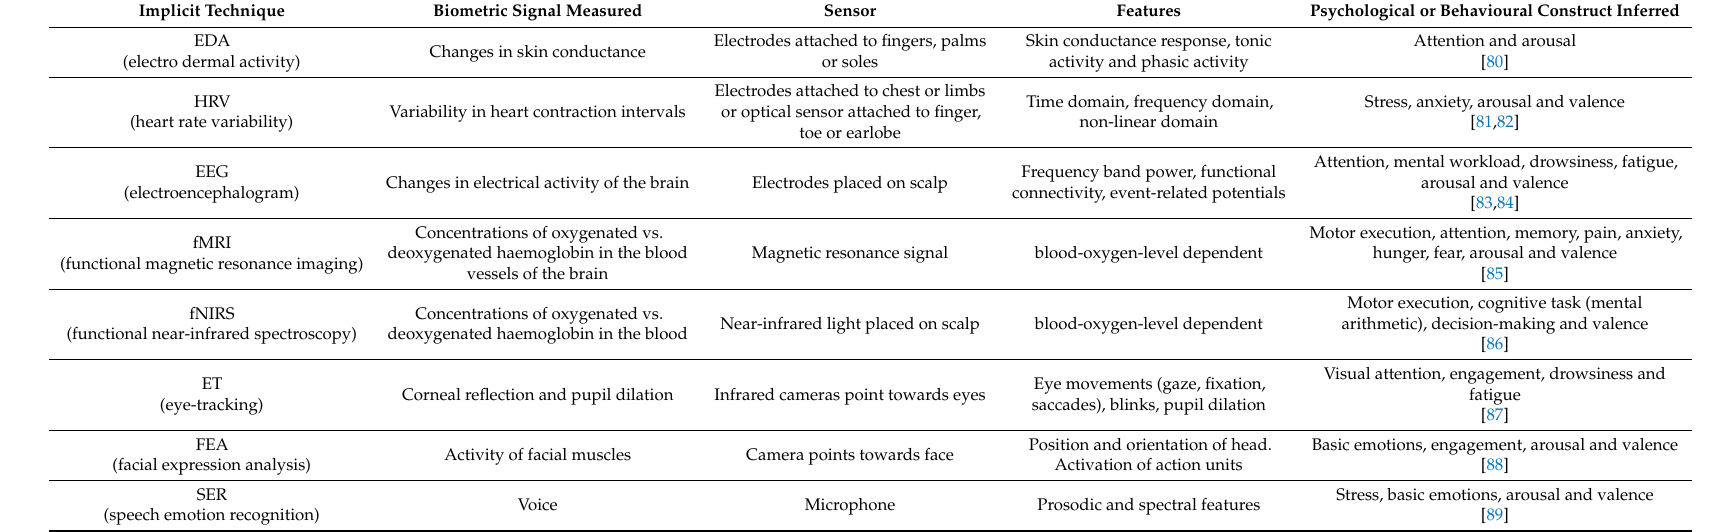
Table 1. Overview of the main implicit techniques used in human behaviour